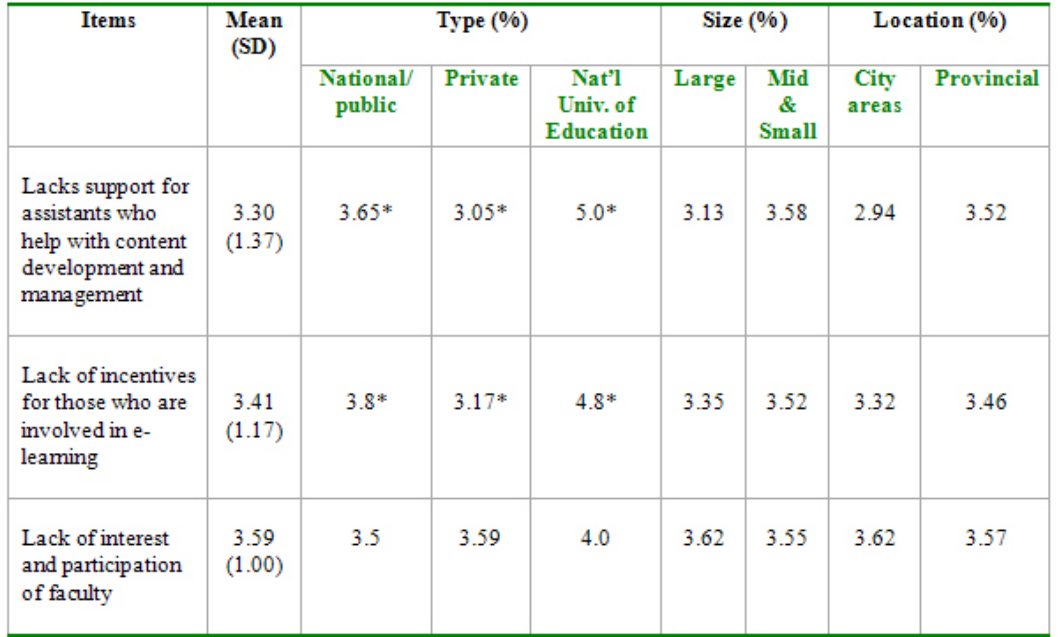
Table 6. Problems Related to the Faculty Support